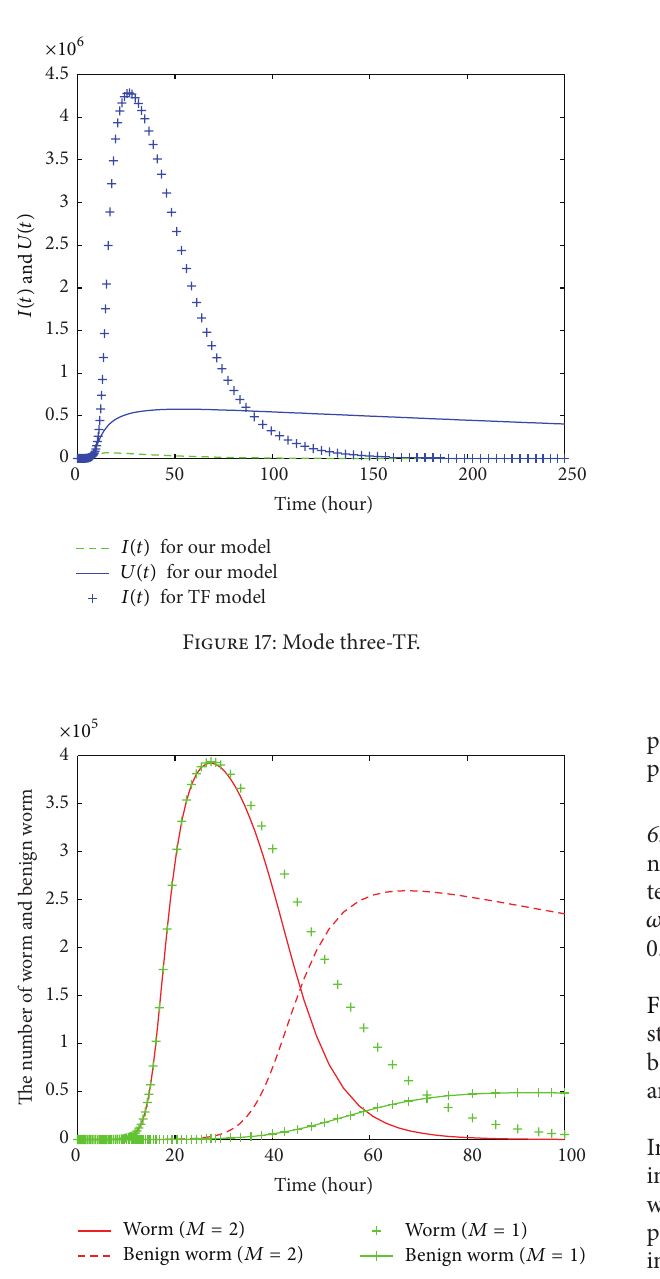
Figure 18: Comparison of different 𝑀 .